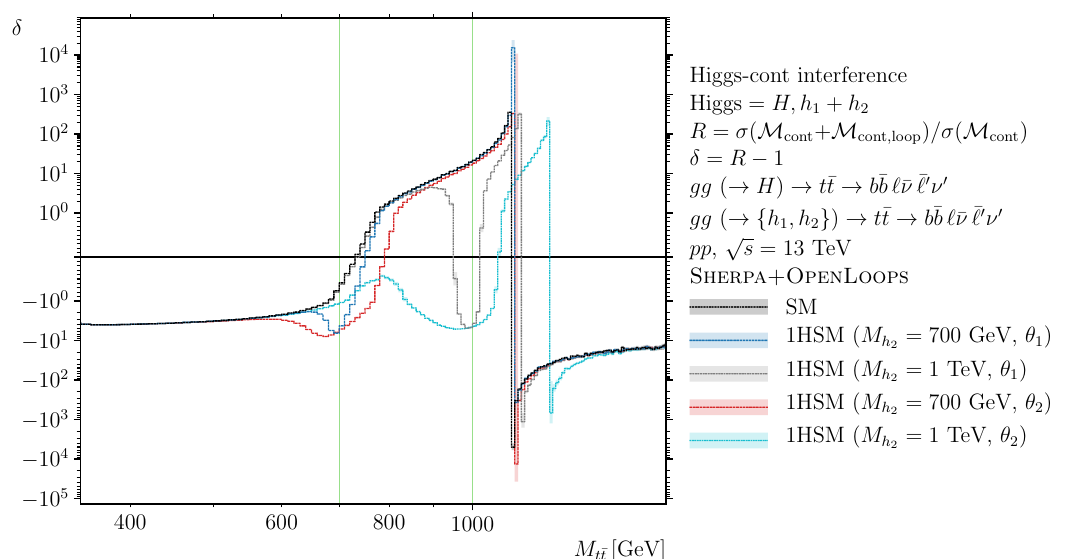
Figure 22 . M distributions of the relative deviation δ = R 1 of the Higgs interference t ¯ t − ) in the SM and 1HSM with the background without and with the virtual corrections ( M cont , loop = 700 , 1000 GeV, θ 1 , θ 2 ) for gg ( h 1 , h 2 , H ) t ¯ t b ¯ b (cid:21) ¯ ν ¯ (cid:21) (cid:31) ν (cid:31) in pp collisions at ( M h 2 { } { } → { } → → √ s = 13 TeV. R is the ratio of σ (I( H ,C + (cid:31) )) to σ (I( H ,C)) and σ (I( h 1+2 ,C + (cid:31) )) to σ (I( h 1+2 ,C)) in the SM and 1HSM, respectively. Other details as in figure 4.